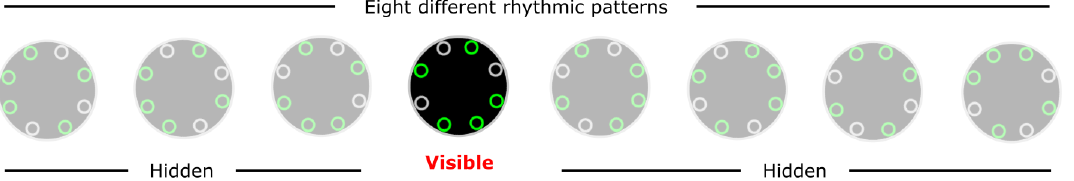
Figure 3. Eight controls with different rhythm patterns, of which one was made visible to user while seven were hidden. Visible control changed randomly during experiment for any trial. If one of hidden control was unintentionally activated, a false positive would be